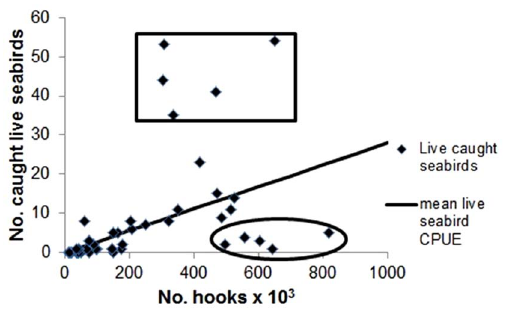
Figure 3. Number of live seabirds observed captured per number of shallow-set hooks set, for 49 Hawaii longline swordfish vessels, 4 May 2004 - 11 October 2012. Solid line is mean live seabird CPUE of 0.028 live birds per 1000 hooks. Outliers with relatively high and low nominal catch rates for live seabirds are identified within the rectangle and oval, respectively, per rules defined in Results section ‘‘ Nominal Total and Live Seabird Catch Rate by Unique Vessel ’’.